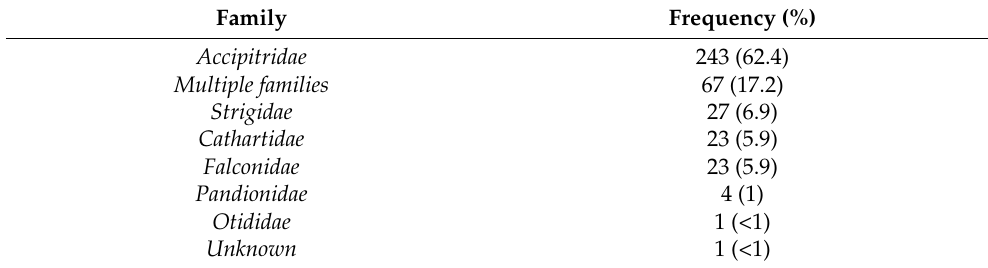
Table 1. Raptor family frequency within the reviewed human-raptor interaction research.